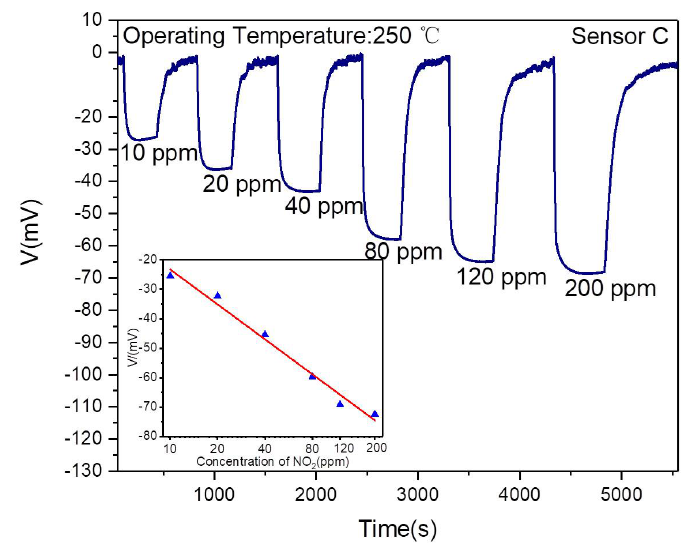
Figure 6. Transient response and recovery characteristics of Sensor C to di ff erent concentrations of NO 2 at 250 ◦ C.